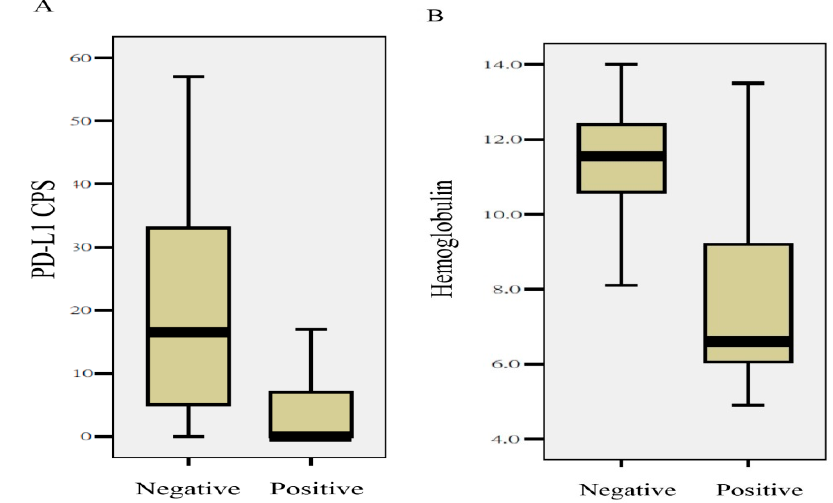
Figure 4. MCL1 amplification associated with quantitative values of the PD-L1 combined positive score (CPS) ( A ), and pretreatment hemoglobulin ( B ) ( p = 0.031 and p = 0.02,